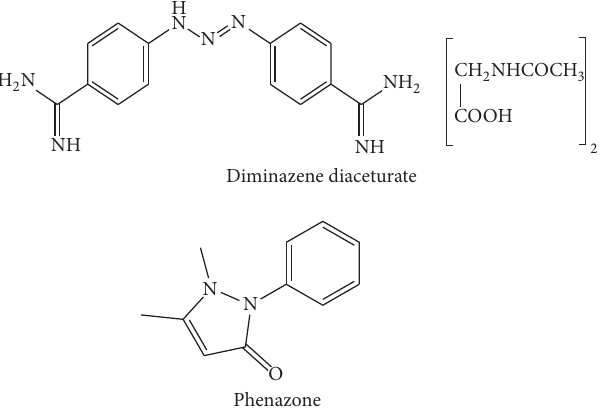
Figure 1: Chemical structure of diminazene diaceturate and